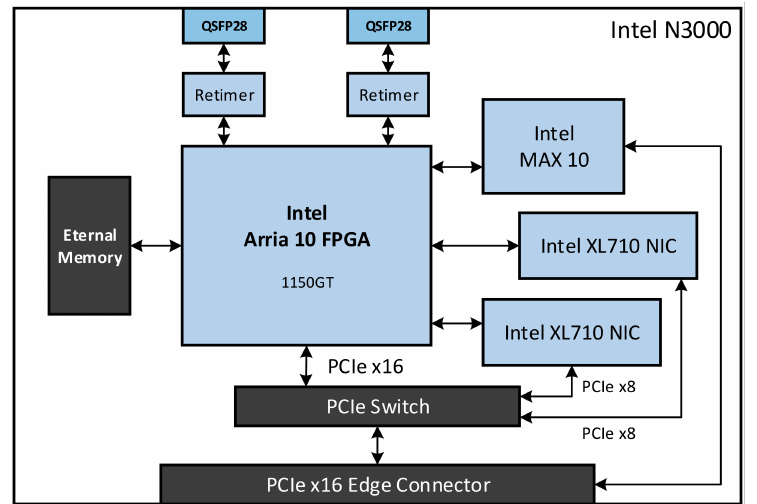
Figure 2. Overall architecture of